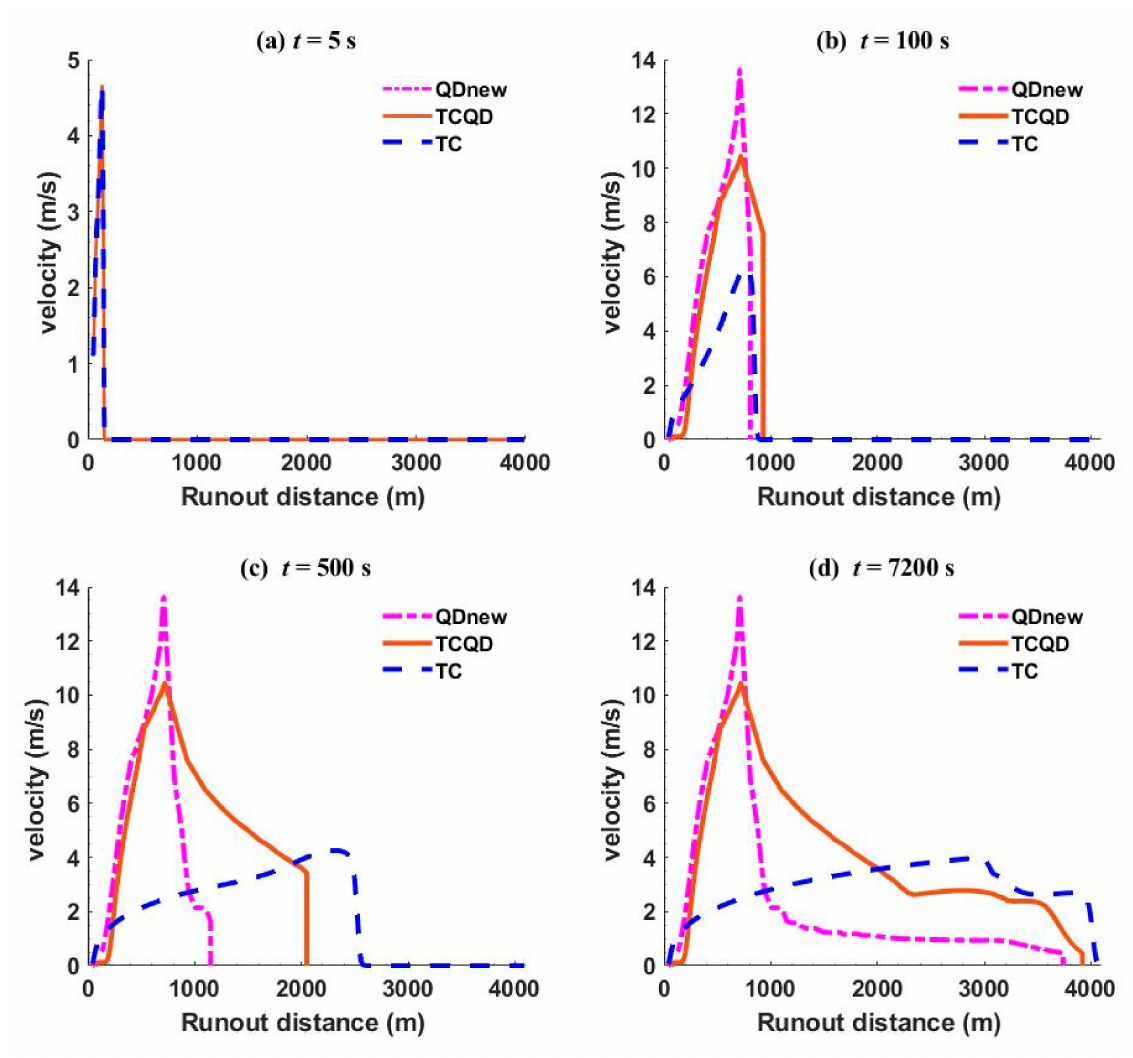
Figure 7. Velocity profiles of QDnew, TCQD, and TC at different times. ( a – d ) show the velocity profiles at 5 s, 100 s, 500 s, and 7200 s,